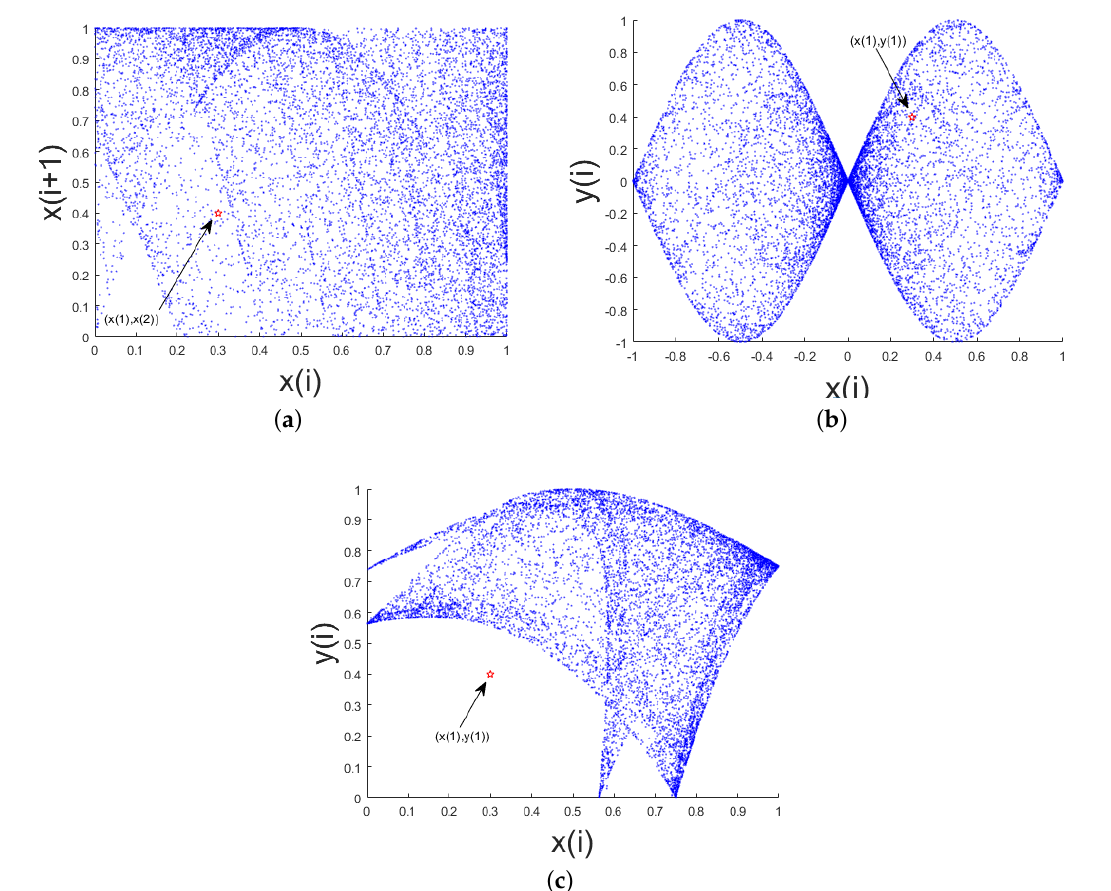
Figure 2. Trajectories of ( a ) FL-NMLD, ( b ) 2D-SIMM, and ( c )